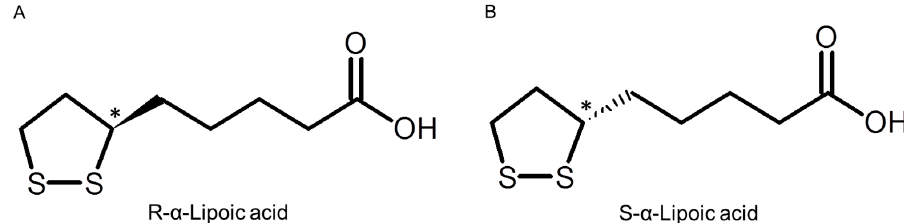
Figure 1. Structure of R - α -lipoic acid ( A ) and S - α -lipoic acid ( B ). Chiral center shown with asterisk (*).